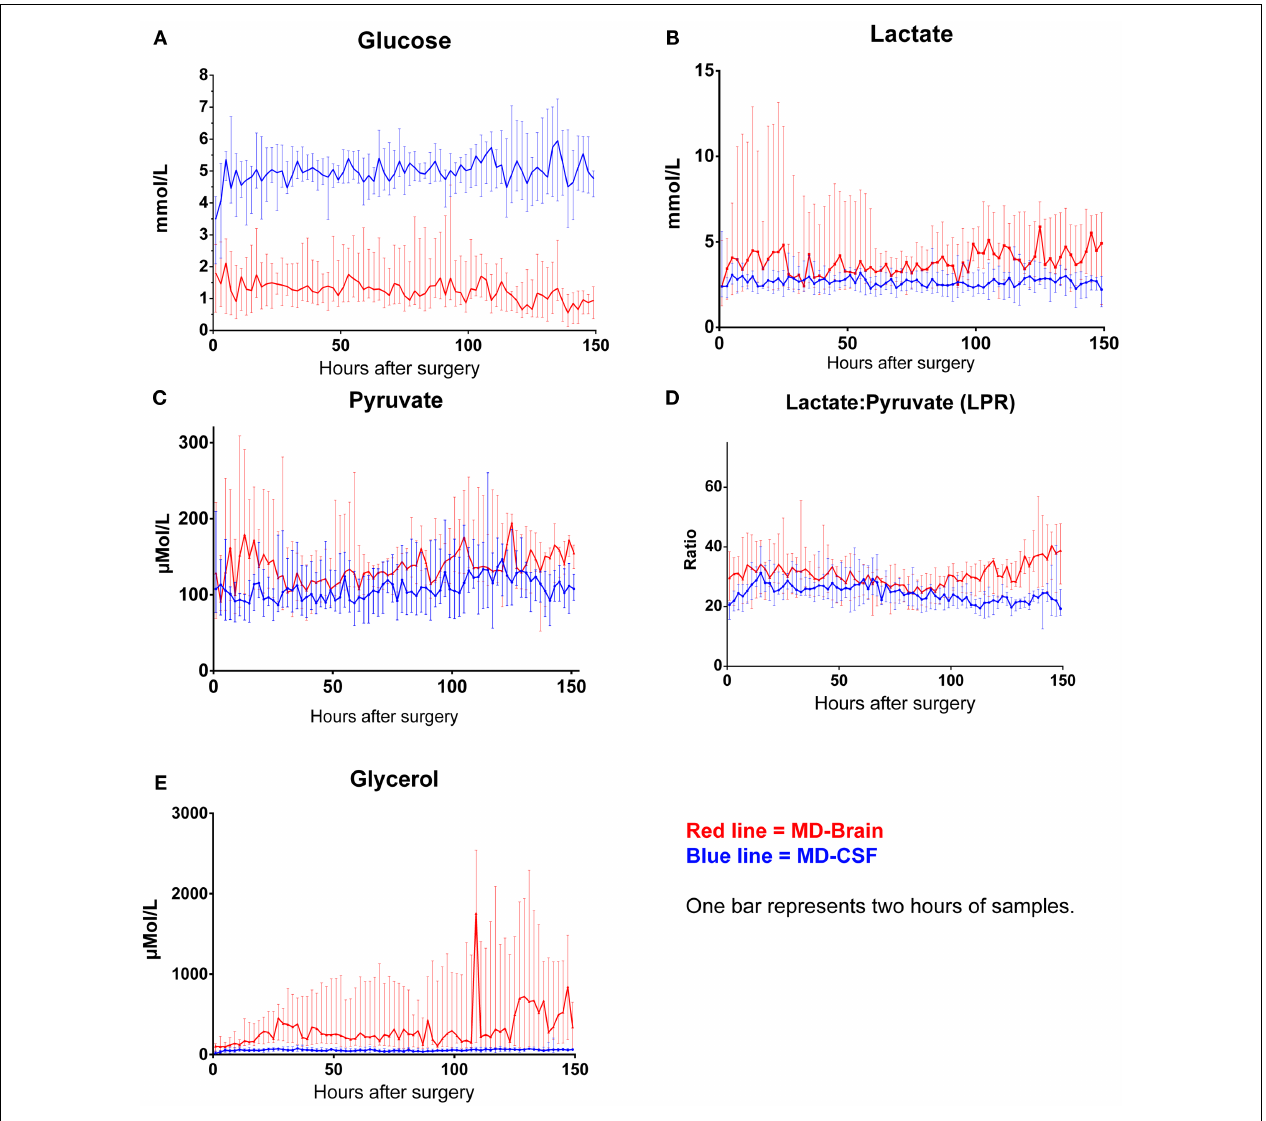
FIGURE 4 | Median ( ± 1st–3rd quartile) CSF-MD and Brain-MD glucose (A), lactate (B), pyruvate (C), LPR (D), and glycerol (E) levels for all patients ( n = 14)